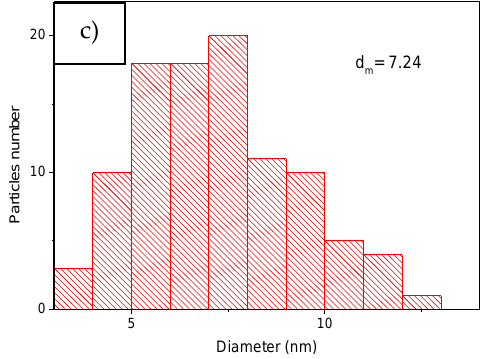
Figure 8. The TEM and HRTEM images ( a ), SAED patterns ( b ) and particle size distribution ( c ) corresponding to TiO 2 SG sample.